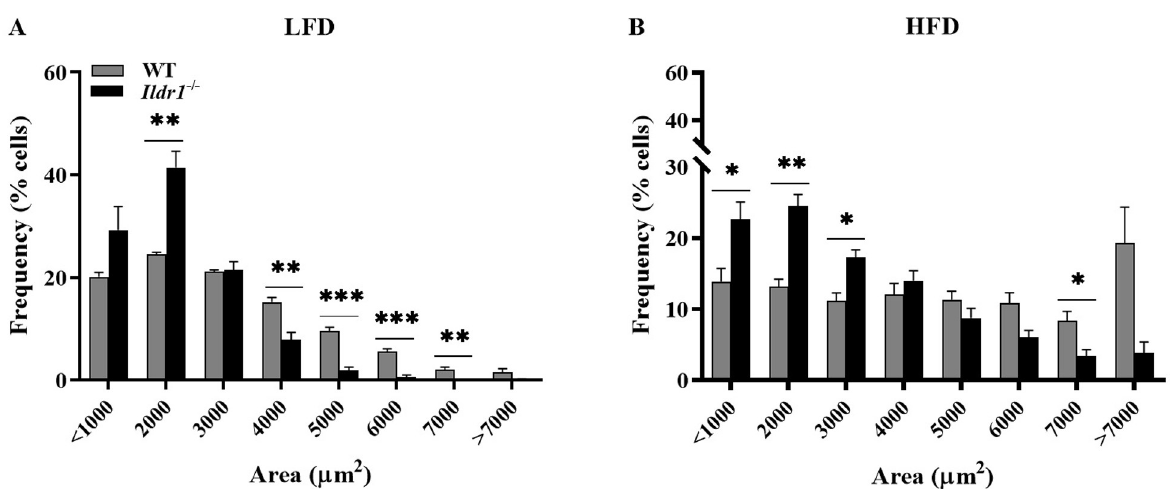
Fig 7. Adipocyte sizes in wild-type (WT, gray bars) and Ildr1 -/- mice (black bars) in a mixture of retroperitoneal and inguinal adipose tissues of mice fed either a low fat (LFD) or high fat diet (HFD). (A) LFD fed mice: 1001–2000 μ m 2 cells [t(6) = 5.373, P = 0.0017]; 3001–4000 μ m 2 cells [t(6) = 4.259, P = 0.0054], 4001–5000 μ m 2 cells [t(6) = 7.999, P = 0.0002], 5001–6000 μ m 2 cells [t(6) = 7.462, P = 0.0003], 6001–7000 μ m 2 cells [t(6) = 3.892, P = 0.0081]; (B) HFD fed mice: < 1000 μ m 2 cells [t(5) = 2.929, P = 0.032], 1001–2000 μ m 2 [t(5) = 6.22, P = 0.0015], 2001–3000 μ m 2 cells [t (5) = 3.811, P = 0.012], 6001–7000 μ m 2 cells [t(5) = 2.804, P = 0.037]. n = 3–4 mice/genotype/diet; � P < 0.05, �� P < 0.01, ��� P < 0.001, WT vs . Ildr1 -/- .